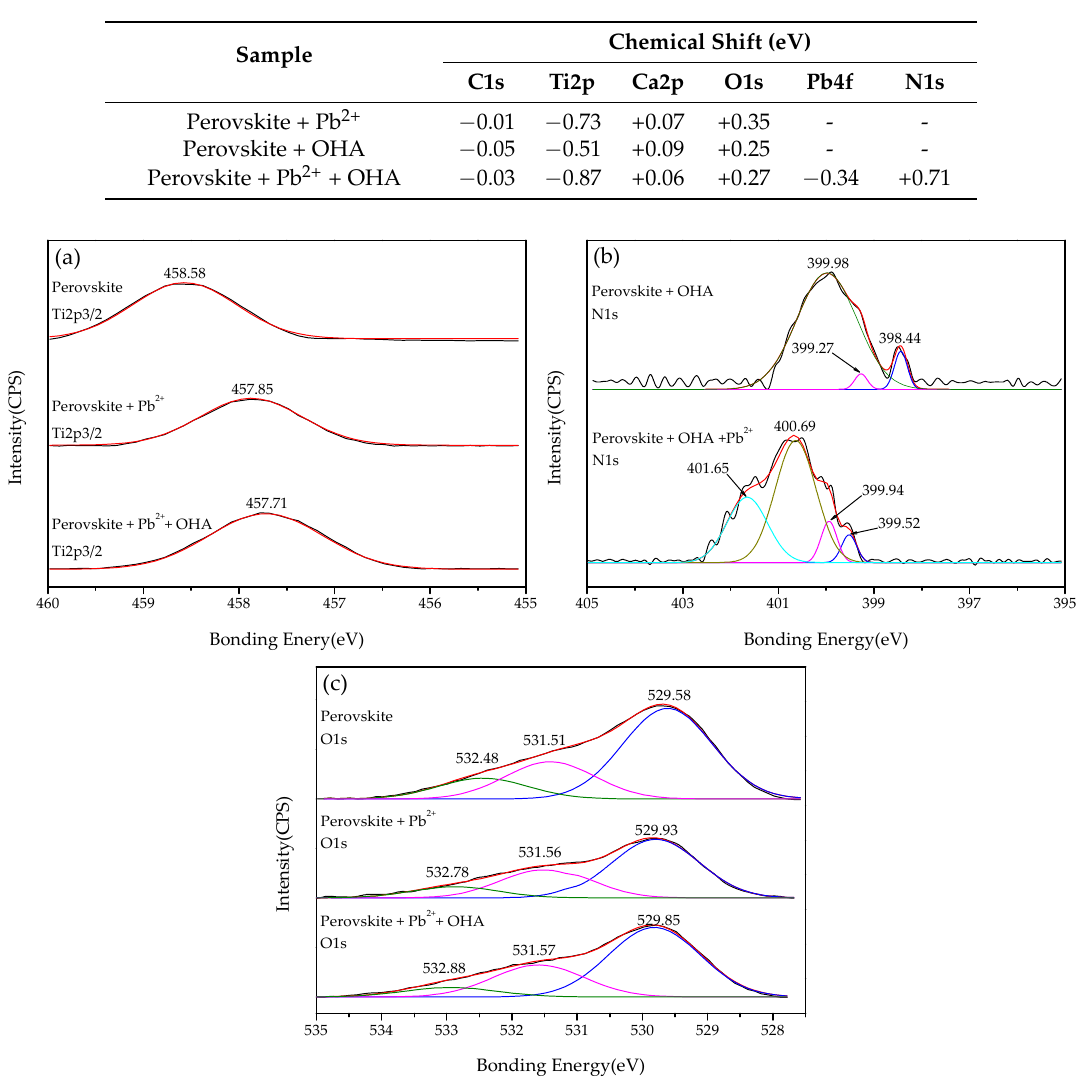
Table 4. Chemical shifts of the elemental binding energies of the perovskite surface.